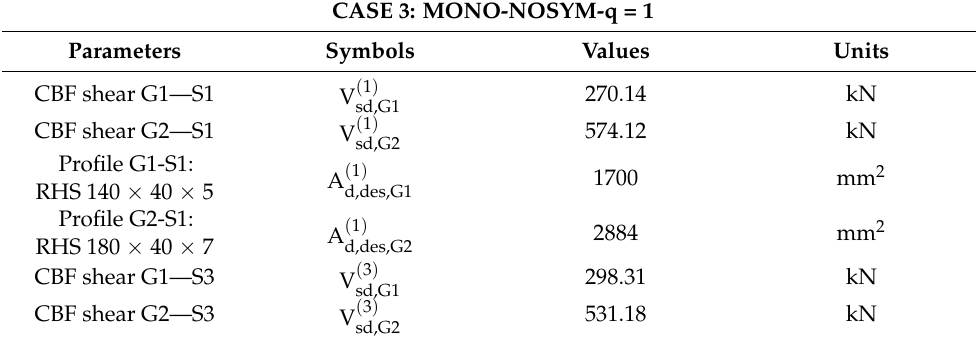
Table 10. Results of case study 4 (G: group; S: